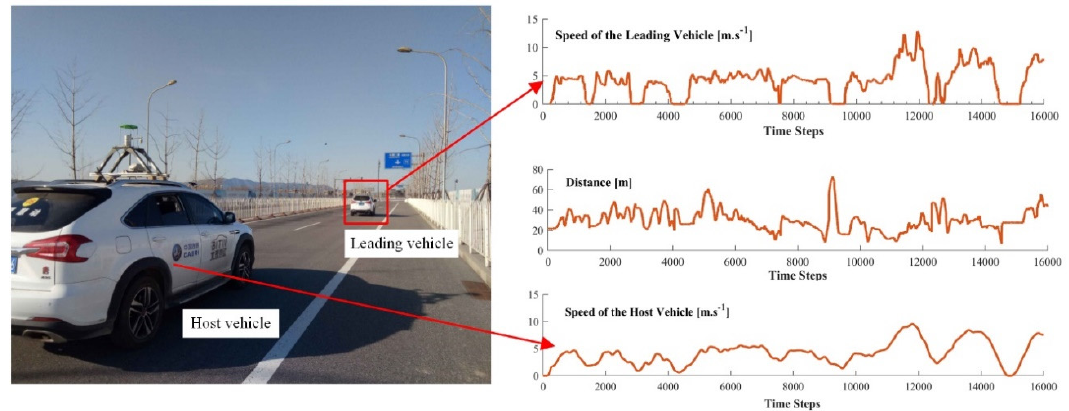
Figure 13. An illustration of the real driving data and vehicles.